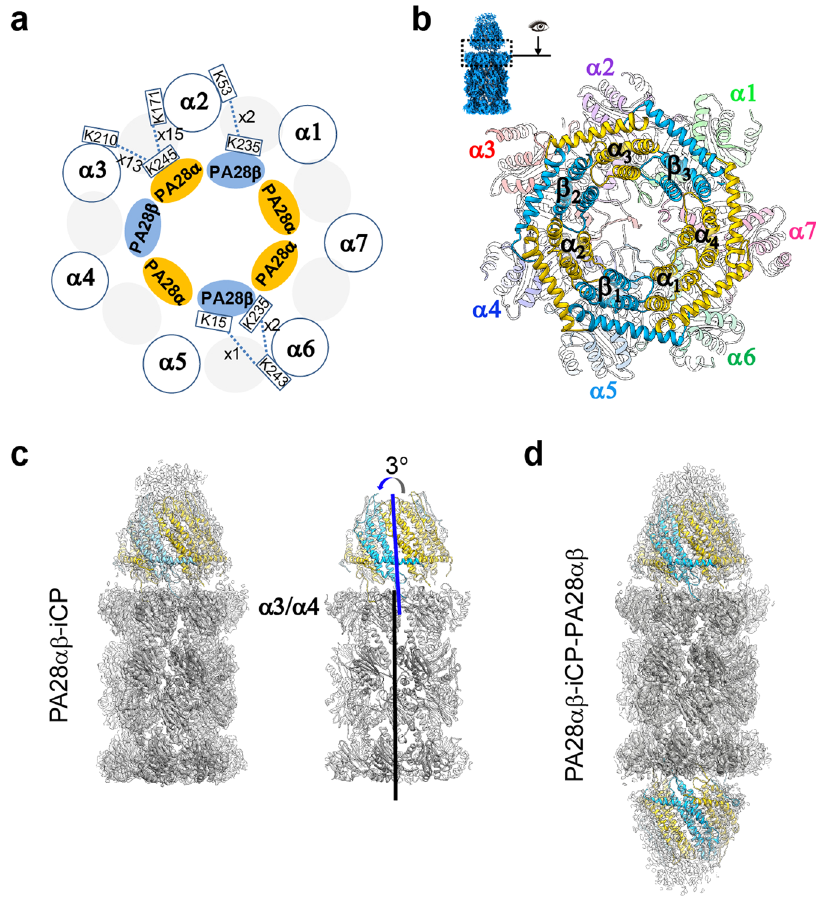
Fig. 2 The spatial arrangement between PA28 αβ and iCP in the PA28 αβ -iCP proteasome. a A carton diagram illustrating the spatial arrangement between PA28 αβ and iCP (blue circles) derived from XL-MS analysis. The PA28 α and PA28 β are shown as sky blue and gold ellipses, respectively, and the color scheme was followed throughout. Identi fi ed cross-linked contacts (only in the interface) between a pair of subunits are shown as dotted lines, with the involved residues and the spectrum count number indicated. We used an E -value of 1.00E − 02 as the threshold to remove extra lower-con fi dence XL- MS data. b Visualization of the PA28 αβ -iCP interface, with the iCP subunits shown in distinct colors and appearing transparent. The visualization angle and region are illustrated in the inset. c Cryo-EM map of PA28 αβ -iCP (transparent gray) with fi tted model (iCP in gray, PA28 αβ in color, left panel). On the right showing the model of PA28 αβ -iCP, with the position of the α 3/ α 4-subunit and the axes of PA28 αβ (blue) and iCP (black) indicated. The axes also indicate the direction of the tilt of PA28 αβ relative to iCP. d Cryo-EM map and model of PA28 αβ -iCP-PA28 αβ